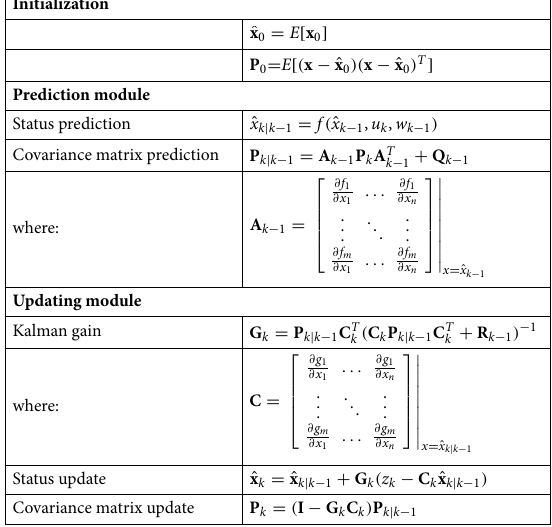
Table 2. Extended Kalman filter